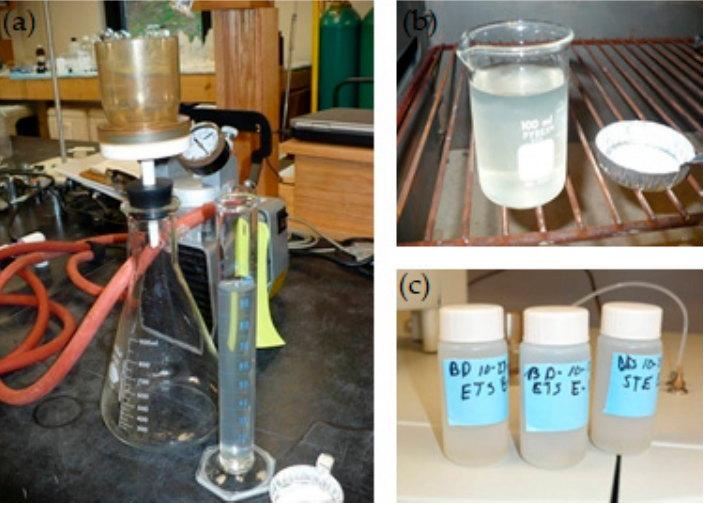
Figure 3. Samples taken in wooded area east of Field 1, 2, and 3 for the study area: ( a ) sample preparation, ( b ) digested solution and ( c ) sample bottle.